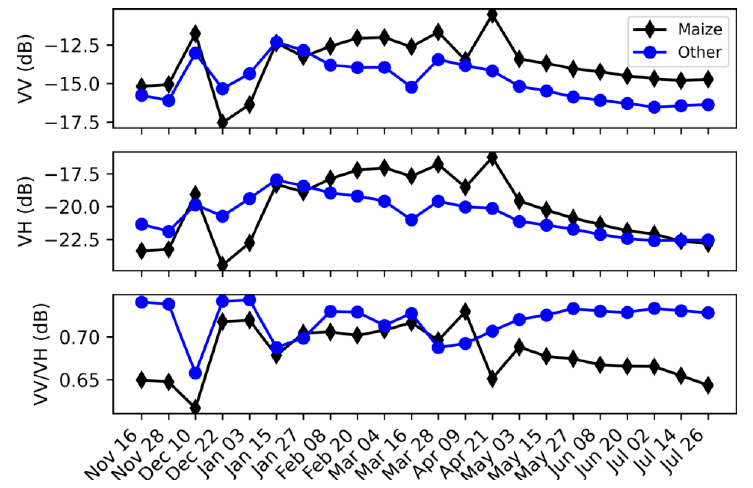
Figure 2. The mean raw VV, VH, and VV/VH backscatter profiles. The extracted polarizations are for maize crops and other classes, which refers to aggregated bare soil and grasslands. for maize crops and other classes, which refers to aggregated bare soil and